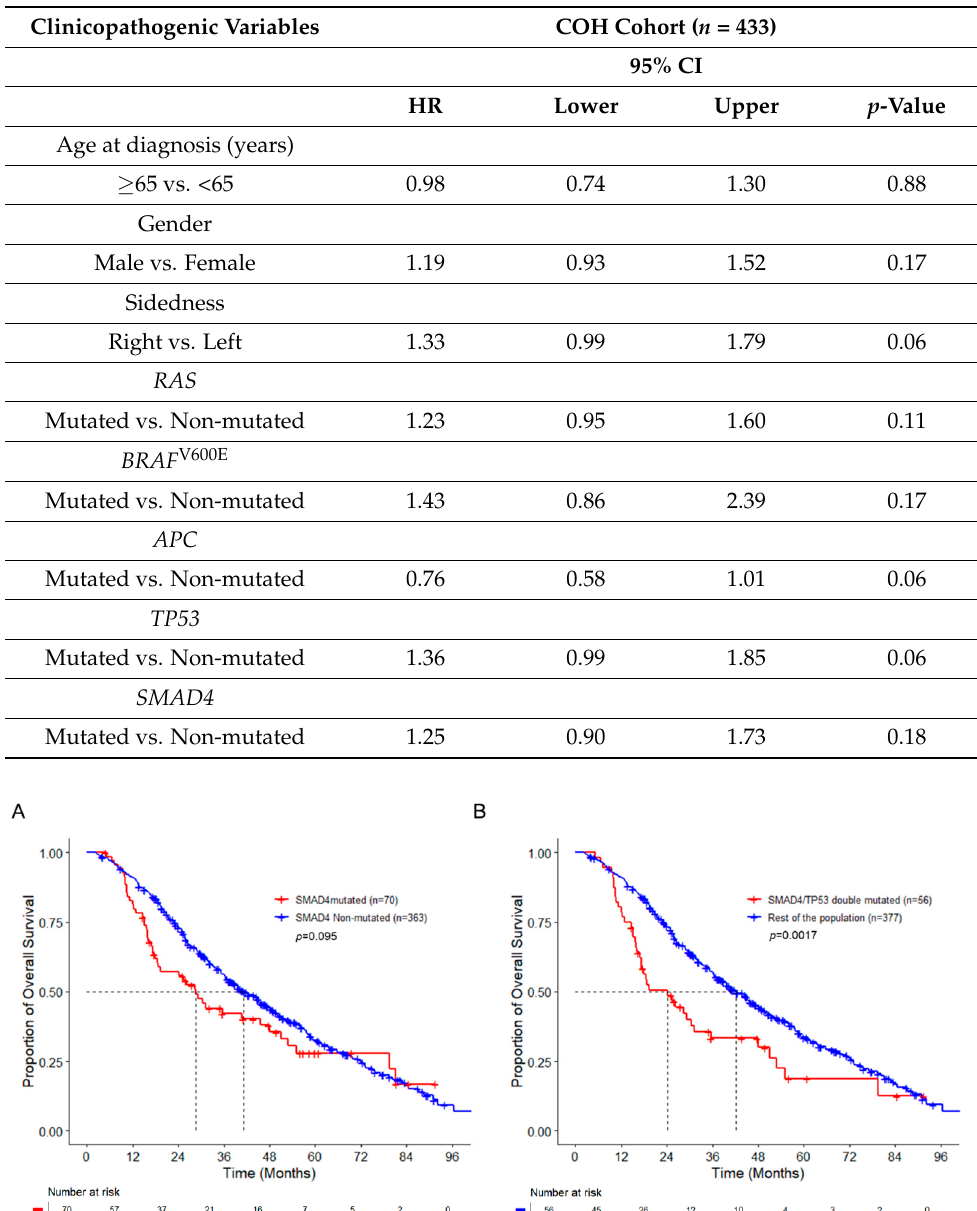
Table 2. Multivariate survival model analysis for OS in 433 patients.